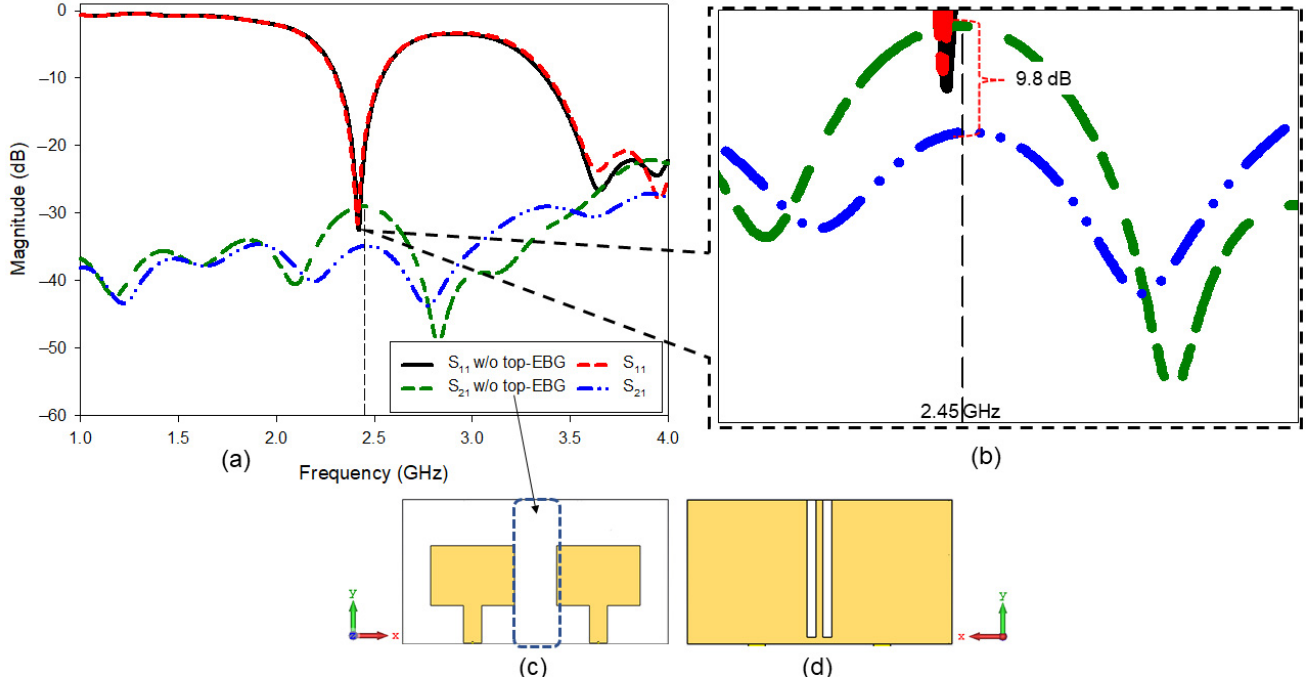
Figure 10. Investigation on the effect of strip line (without EBG top layer) at the back of the antenna: ( a ) S-parameter results, ( b ) enlarged view of the S 12 results at 2.45 GHz, ( c ) front view of the antenna without EBG top layer and ( d ) back view of the antenna without EBG top layer.